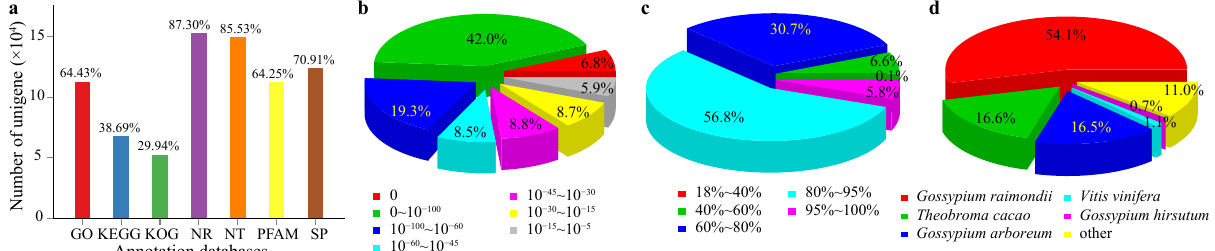
Figure 1. Schematic illustration of transcriptomic data annotation. The transcriptomic sequencing data were annotated against seven databases ( a ). GO, the Gene Ontology database; KEGG, the Kyoto Encyclopedia of Genes and Genomes database; KOG, the euKaryotic Ortholog Groups database; NR, the NCBI None-Redundant protein sequences database; NT, the NCBI NucleoTide sequences database; PFAM, the Protein FAMily database; SP, the Swiss-Prot database. Meanwhile, the blast results against the NR database were also presented, including distributions of e-values ( b ), sequence similarities ( c ), and best annotated species ( d ),